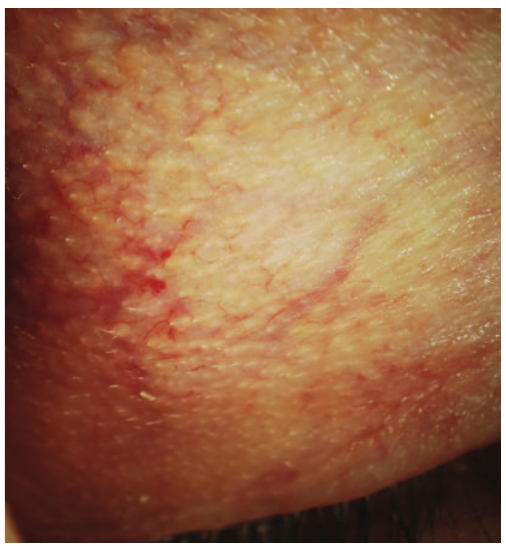
Figure 1: Vascular Tortuosity of the Upper Eyelid (VTUE) severe grade with telangiectasia and microaneurysms.